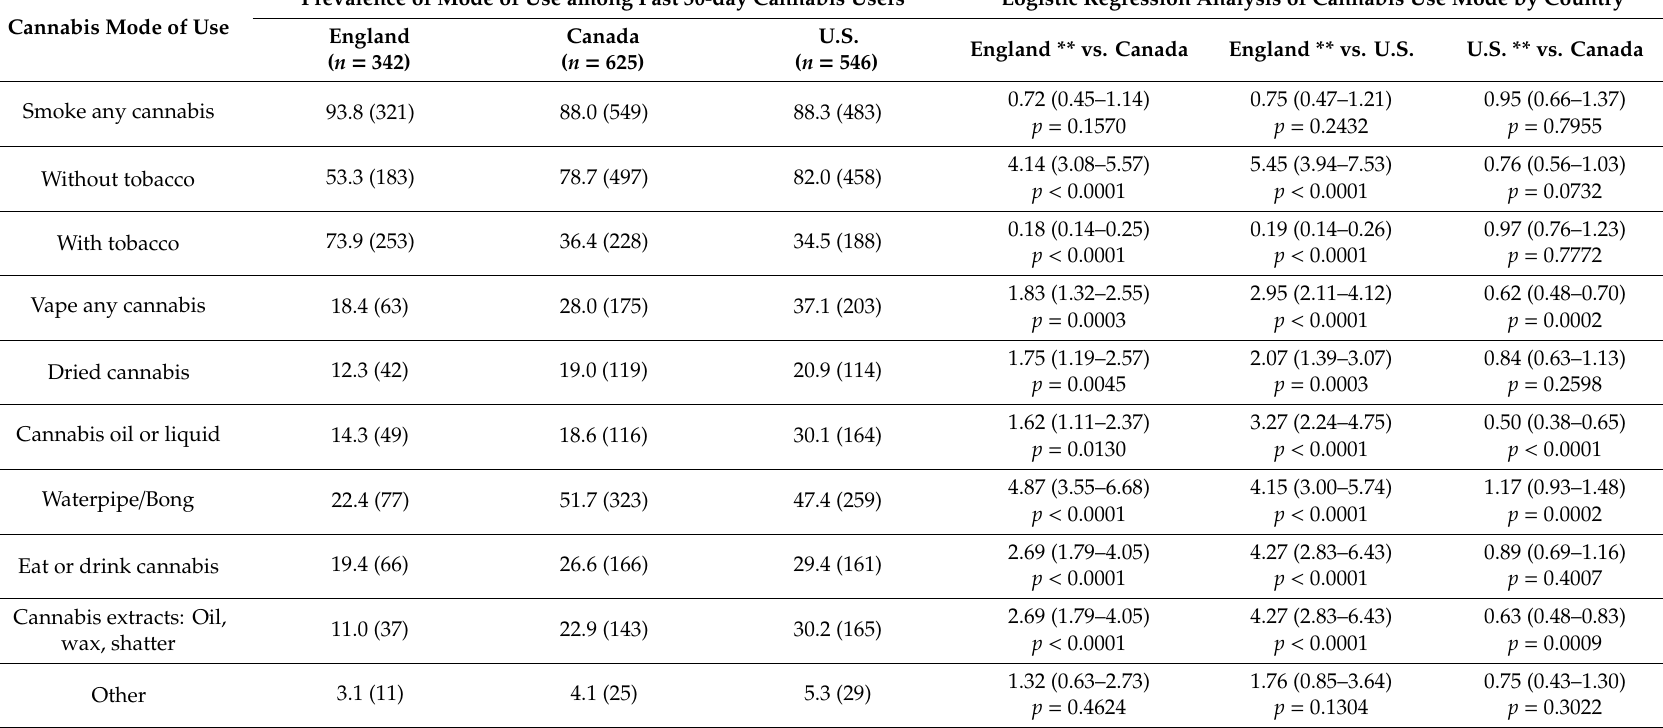
Table 3. Prevalence of past 30-day cannabis modes of use among past 30-day cannabis users and binary logistic regression analysis of cannabis modes of use by country (weighted)